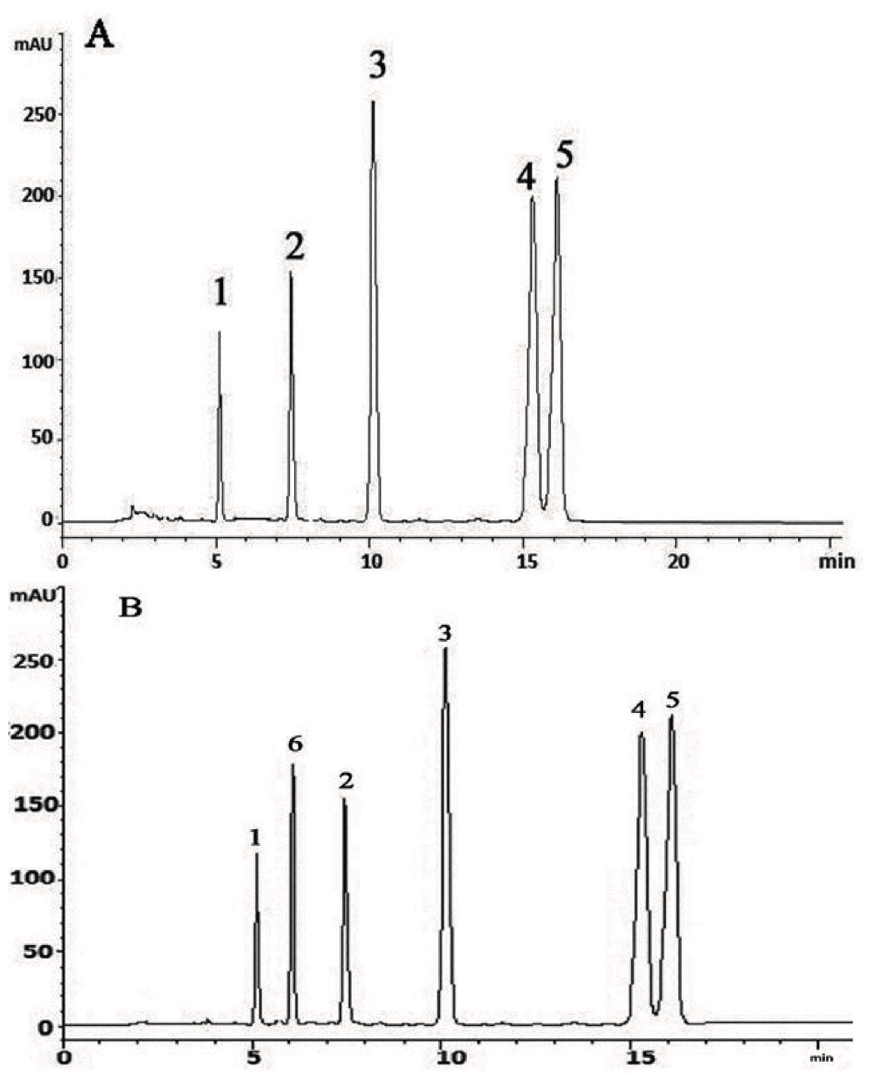
Figure 8. Representative HPLC chromatograms of; ( A ) of standards mixture; ( B ) With internal standards. (2 S )-7-Hydroxy-5-methoxy-6,8-dimethyl flavanone ( 1 ), ( S )-5,7-dihydroxy-6,8- dimethyl flavanone ( 2 ), ( E )-2 ʹ ,4 ʹ -dihydroxy-6 ʹ -methoxy-3 ʹ ,5 ʹ -dimethylchalcone ( 3 ),